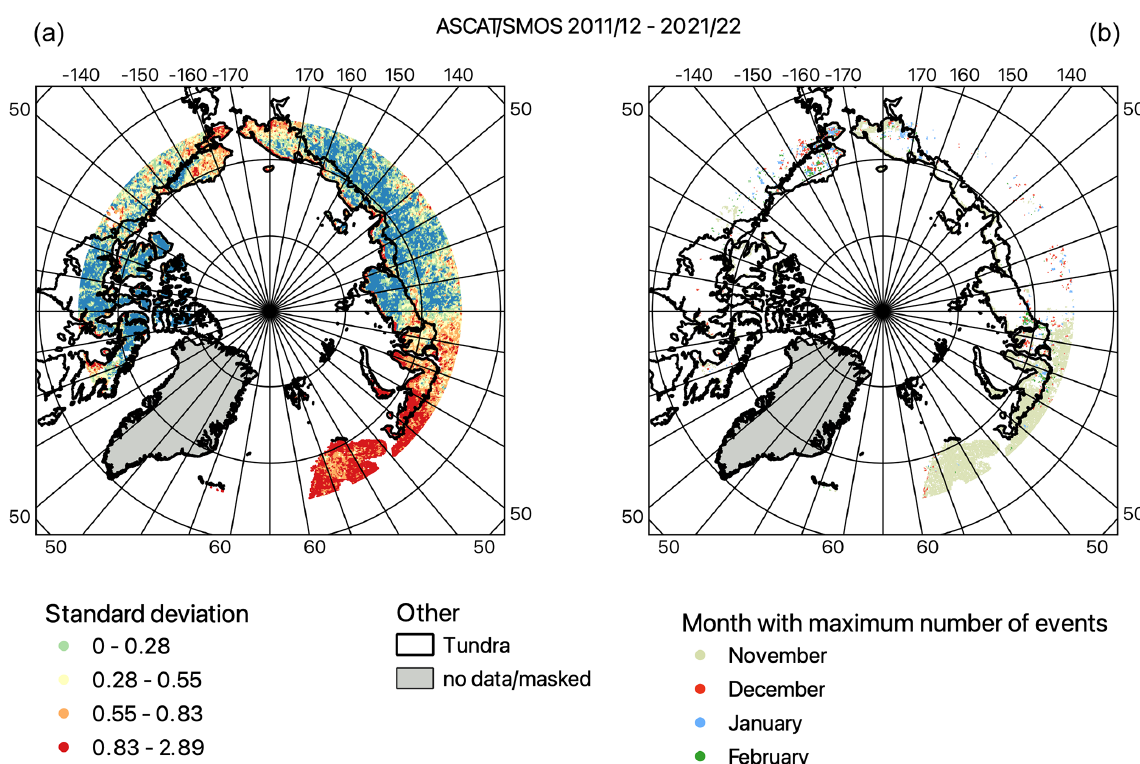
Figure 8. ASCAT–SMOS-derived potential events per winter (November to February, north of 65 ◦ N) and grid cell: (a) standard deviation (blue – no events); (b) month with maximum number of events (tundra extent source: CAVM; Raynolds et al., 2019).